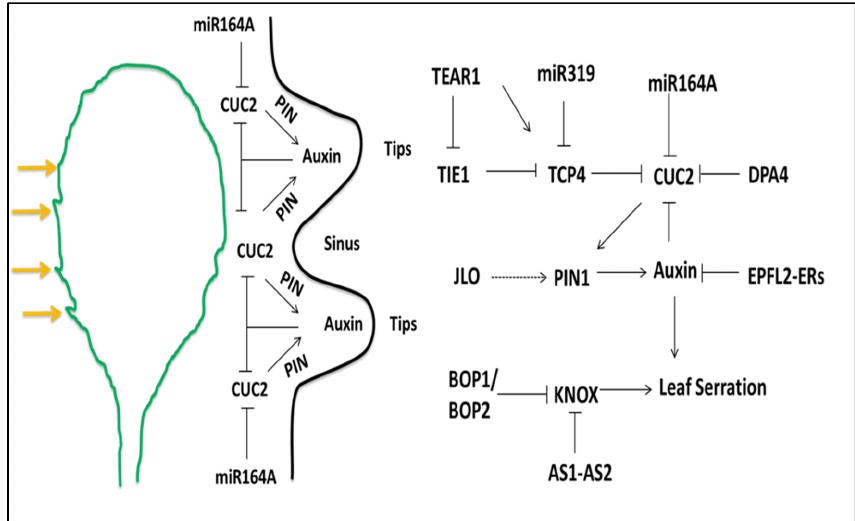
Figure 3. Schematic depiction of the factors involved in the modification of leaf margins, the genetic interaction between different genes and hormones cause the formation of leaf serration. The CUC2 gene promotes the auxin maxima via PIN1 efflux protein in the epidermal cell. The high concentrations of auxin at the tips block, the expression of CUC2 and thus, the expression of CUC2 gene is restricted to the sinus region of the leaf; miR164A also suppresses the CUC2 expression. The other regulatory factors shown in the figure is discussed in detail in the text (the positive and negative regulations are indicated by pointed and T-shaped arrows, respectively).